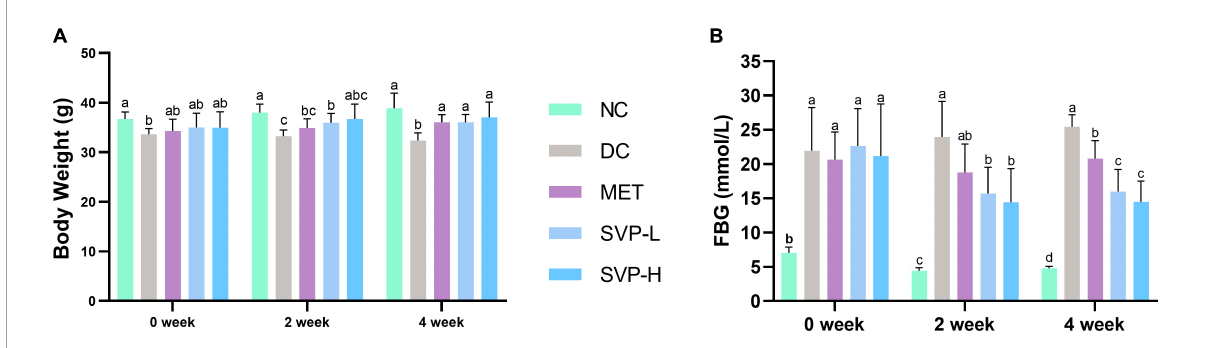
FIGURE2 Effects of oral SVP on the body and blood glucose-related indexes in T2DM mice at 0th, 2nd, and 4th week. (A) Body weight levels; (B) fasting blood glucose levels. Different superscript letters indicate statistically significant differences between the groups ( p <